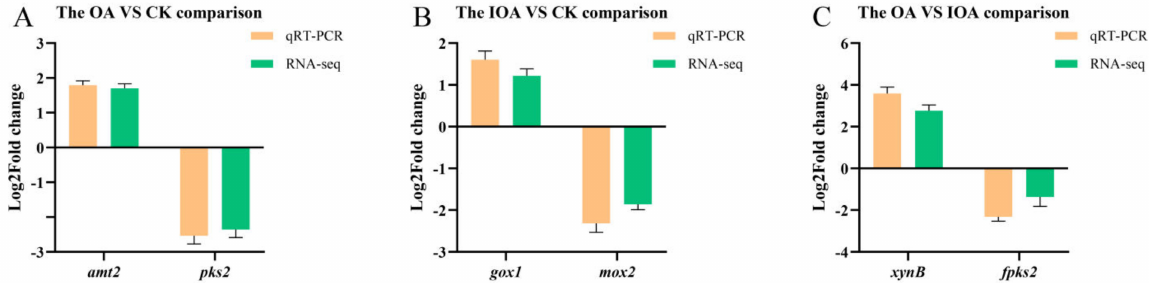
Figure 5. Validation of the DEGs using qRT-PCR. Fold changes of the expression profiles of 6 randomly selected DEGs in 3 comparisons between groups. Each experiment was normalized by the 18S rbs